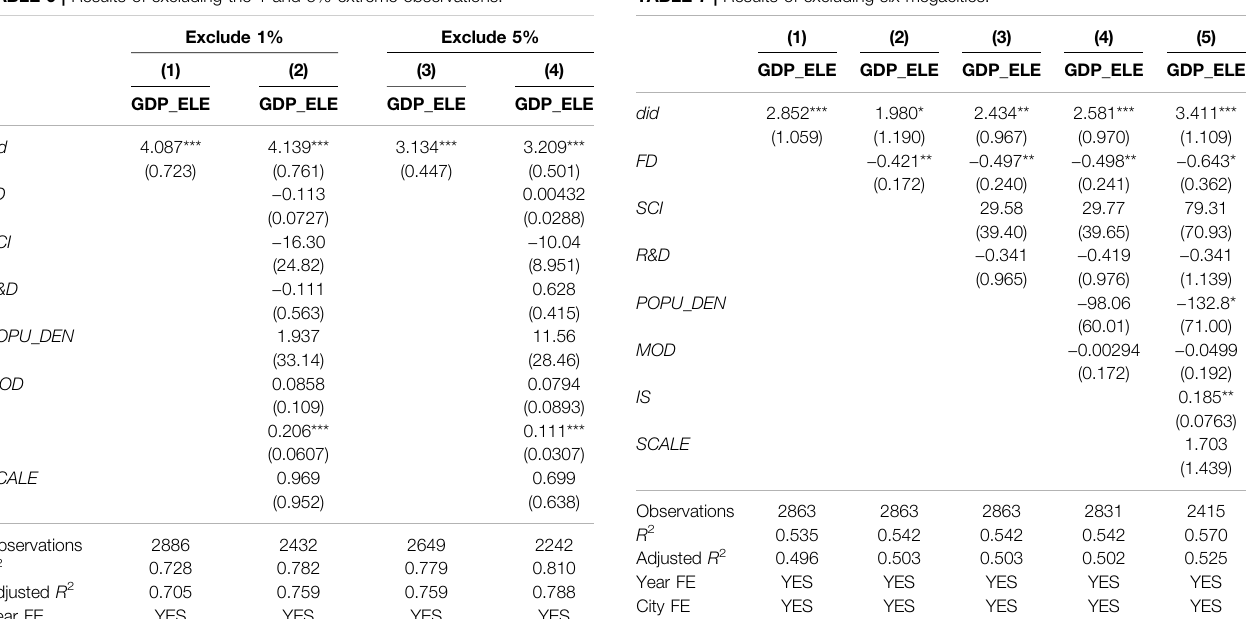
TABLE 6 | Results of excluding the 1 and 5% extreme observations. TABLE 7 | Results of excluding six